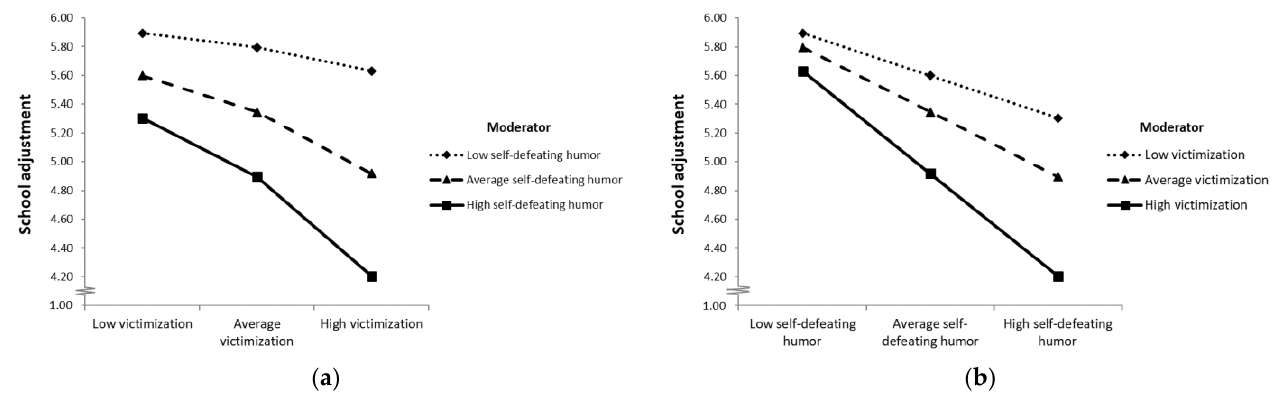
Figure 4. Profile plot of the ordinal interaction effect of self-defeating humor style and victimization on school adjustment. ( a ) Psychological school adjustment (plotted on the vertical axis) as a function of victimization (low, average and high; plotted on the horizontal axis) for different levels of self- defeating humor style use (low, average and high; plotted as separate lines). ( b ) Psychological school adjustment (plotted on the vertical axis) as a function of self-defeating humor style use (low, average and high; plotted on the horizontal axis) for different levels of victimization (low, average and high; plotted as separate lines). Note. Data for visualizing the conditional effects were taken from the syntax output of the PROCESS macro 4.00 [52]. Values for victimization (low = 1.00; aver- age = 1.87; high = 3.31); values for self-defeating humor style (low = 1.98; average = 3.23; high = 4.48).